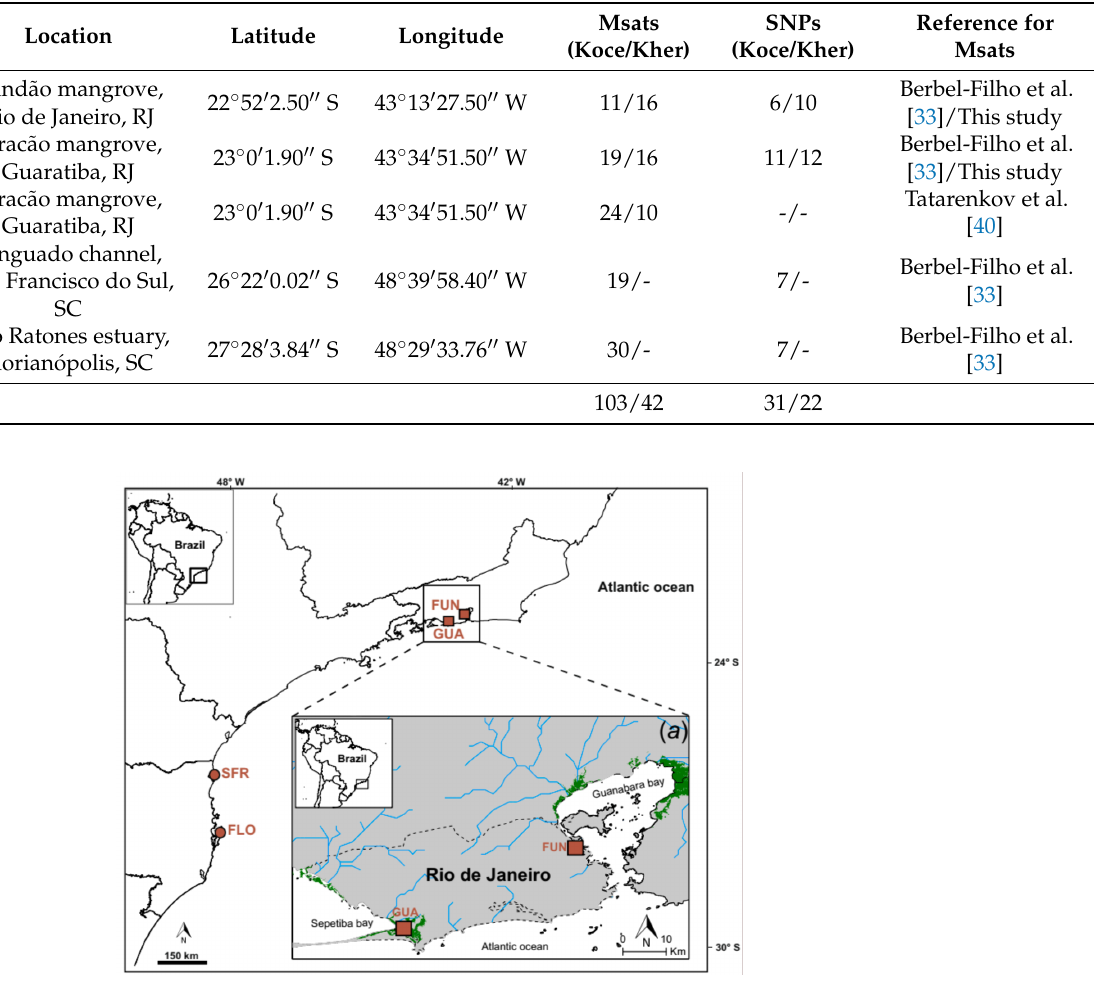
Table 1. Sampling localities and sampling sizes for Kryptolebias ocellatus (Koce) and Kryptolebias hermaphroditus (Kher) in south and southeast Brazil. Microsatellites information for Guaratiba (GUA in Figure 1) was extracted from individuals sampled in two different sampling periods, 2017 and 2007. ‘Msats’ refers to sampling sizes for microsatellites. ‘SNPs’ refers to final sampling sizes using single-nucleotide polymorphisms. ‘Reference for Msats’ refer to references from which microsatellite data was extracted. RJ, Rio de Janeiro State; SC, Santa Catarina State. Asterisks denote sympatric populations.